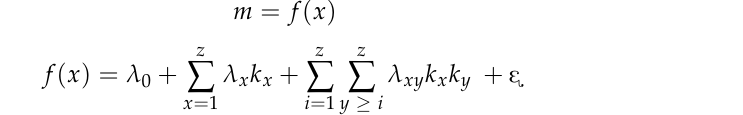
Table 1. Design matrix for COD and NH 4+ − N removal. Symbol Ranges and Codes Independent Variables k Low Center High GSBE conc. (%) k x 20 60 100 HRT (days) k y 1 2